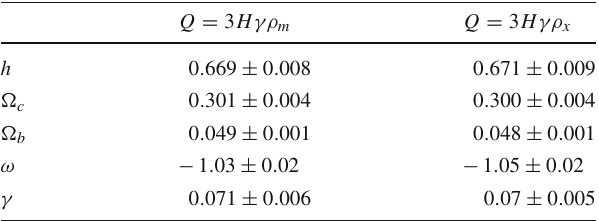
Table 1 Best fit values of the cosmological parameters for the interac- tion models using SNIa+ H ( z ) +BAO+ f gas + CMB